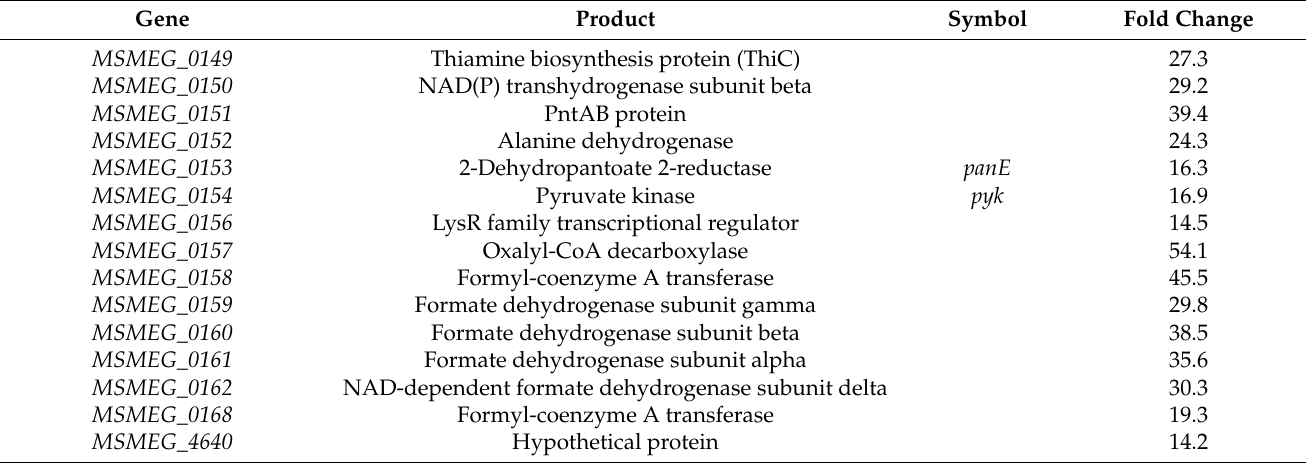
Table 1. Genes differentially expressed in the ∆ F6 strain compared to the